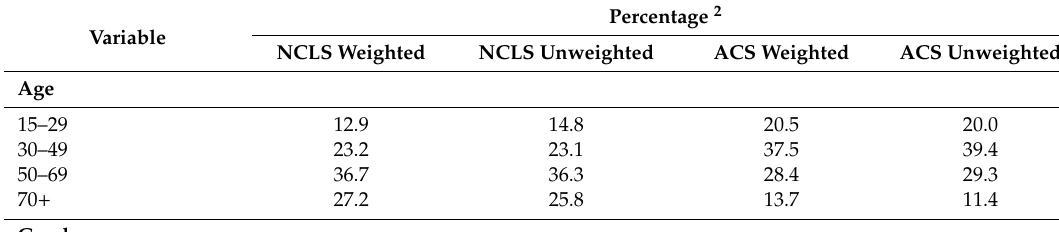
Table A1. Demographics of NCLS and ACS samples (weighted and